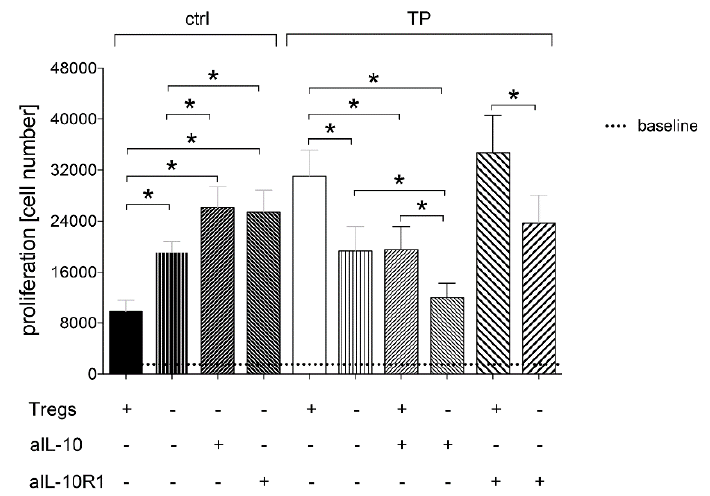
Figure 4. The proliferation rates in absolute cell numbers of CD4 + cells with ( + ) and without ( − ) regulatory T cells (Tregs) in healthy volunteers (ctrl, n = 10) and severely traumatized patients (TP, n = 25) as well as depending on IL-10 neutralization (aIL-10) and IL-10 receptor blockade (aIL-10R1) is shown. Data are shown as mean ± SEM. p < 0.05 * vs.